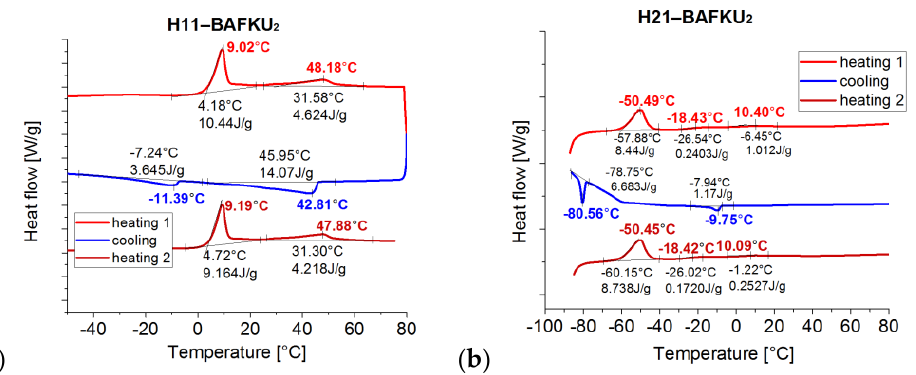
Figure 3. DSC traces of the copolymers (a) H11–BAFKU 2 and (b) H21–BAFKU 2 .